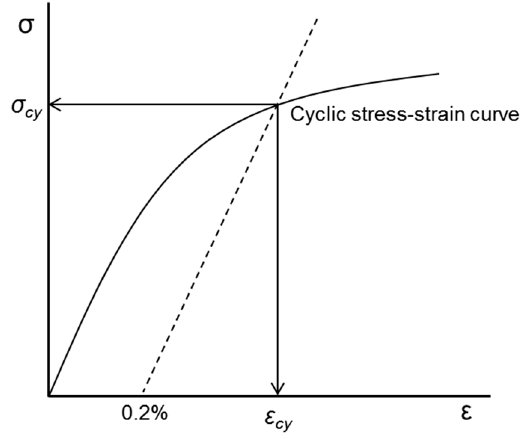
Figure 14. Definition of cyclic yield strength and strain.